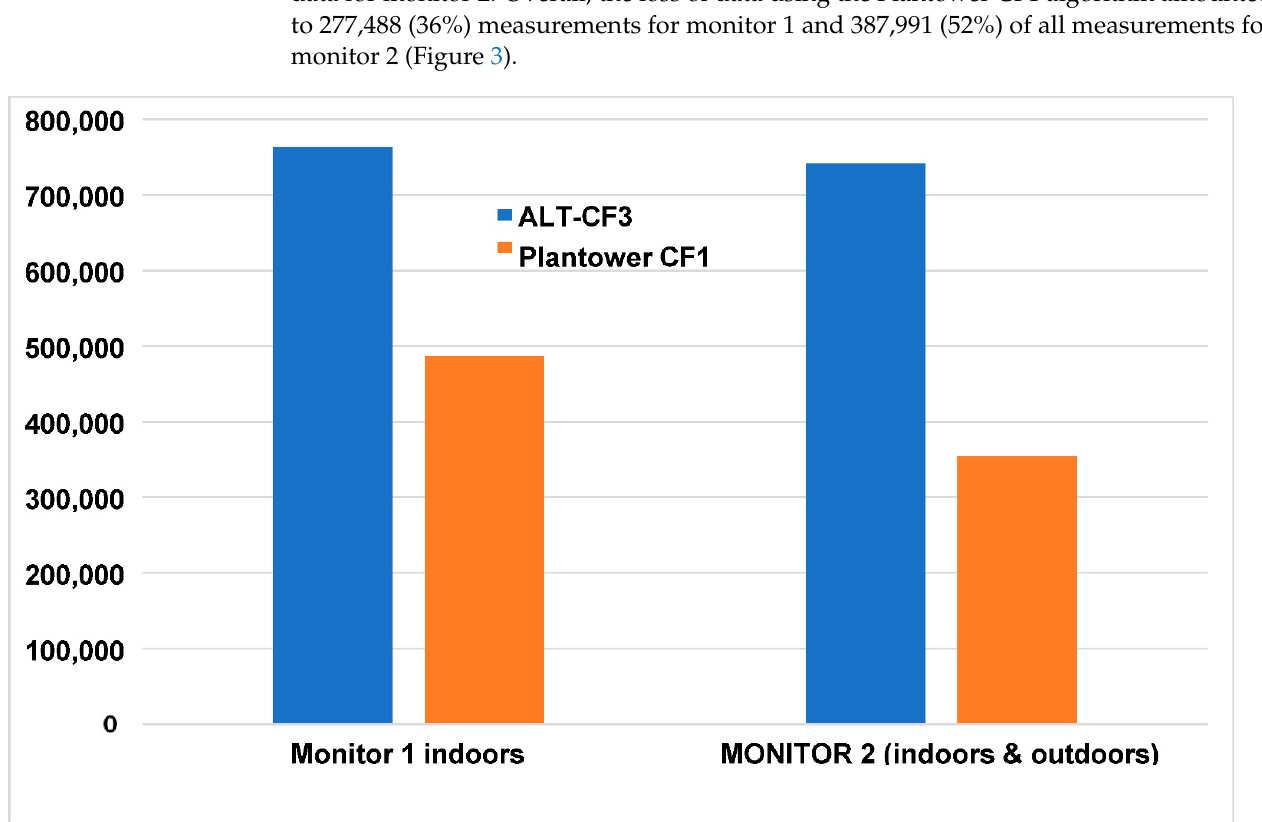
Figure 3. Total observations remaining after applying an upper precision limit of 0.2 (20%). The loss of observations over a 3 year period for the Plantower CF1 algorithm com- pared to the ALT-CF3 algorithm was 36% for monitor 1 and 52% for monitor 2. Table 1. Precision compared using ALT-CF3 and Plantower CF1 algorithms. Time period: 1 October 2019 to 14 January 2022. Lower Upper Valid N Mean Std. Err. Median 90th %Tile Max Quartile Quartile ALT-CF3 algorithm (using precision cutoff of 0.2) Monitor 1 indoors 0.2 For the 18 month second period employing monitors 3 and 4, the loss of data due to employing the CF1 algorithm was similar for the indoor data at 33%, but improved for the outdoor data (20%) (Table S5).